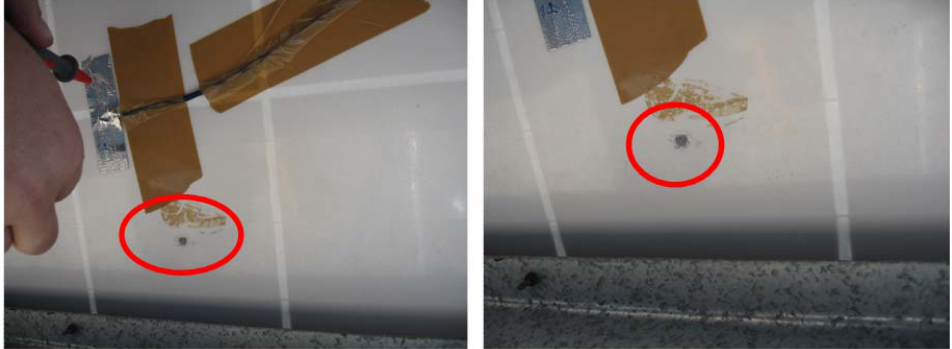
Figure 8. Little holes in the PET film of the PV panel to measure the temperature.